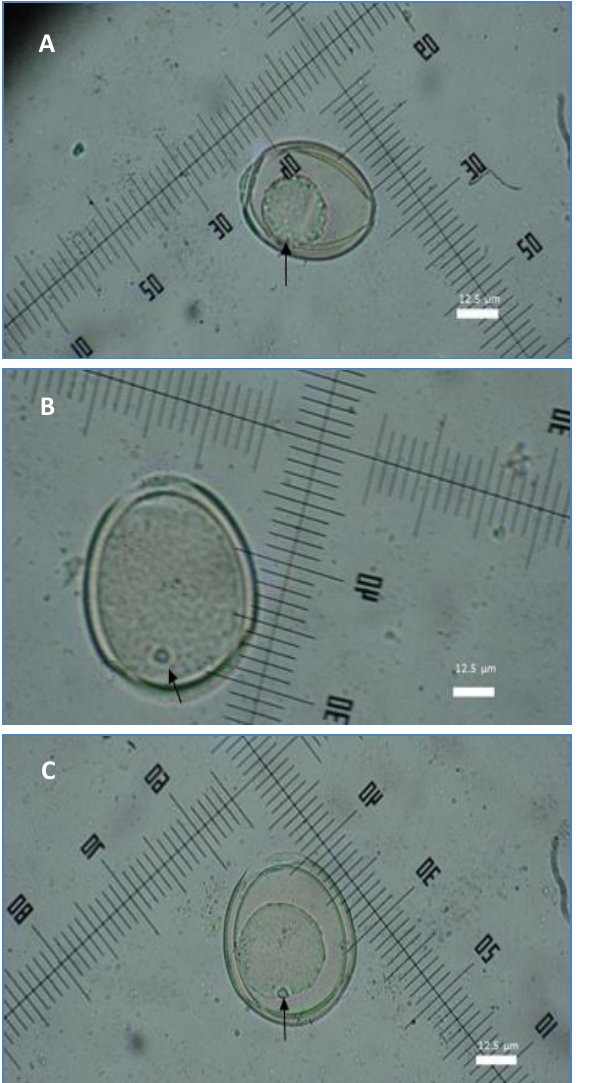
Figure, 4: Eimeria minasensis (A), with cup and micropyle, E.megaembryonia (B) with no cup but micropyle and E. ninakohlyakimovae (C) with no cup but micropyle, all species have clear germinal disk with outer and inner layer by saturated salt solution